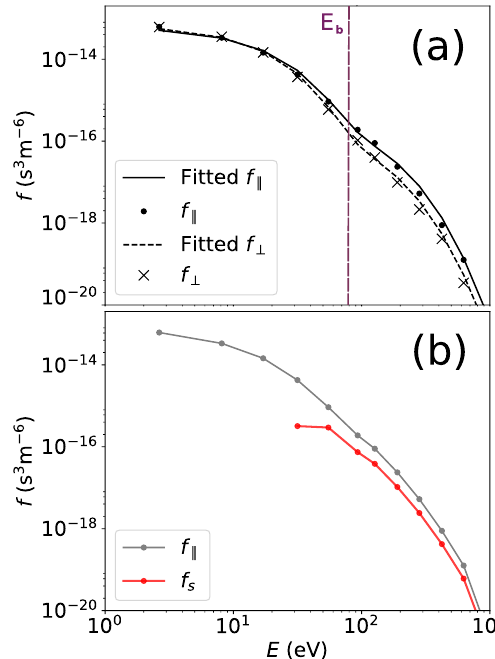
Figure 2. Example electron distribution functions calculated from time-averaged WIND-3DP flux data. Both (a) and (b) plot f (E) on logarithmic axes. Spacecraft potential corrections have been ap- plied to each. Panel (a) shows data overlaid with fitted curves as described in the text. f 1 is enhanced over f ⊥ due to the presence of the strahl population at energies > ∼ 100eV. An estimate of the break-point energy E b is shown in purple. Panel (b) shows an exam- ple f s distribution calculated as described in the text. Also shown is the corresponding f 1 distribution. f s makes up a significant portion of f 1 at energies > 100eV. f s drops off rapidly below this energy and is non-physical below 30eV as it is numerically